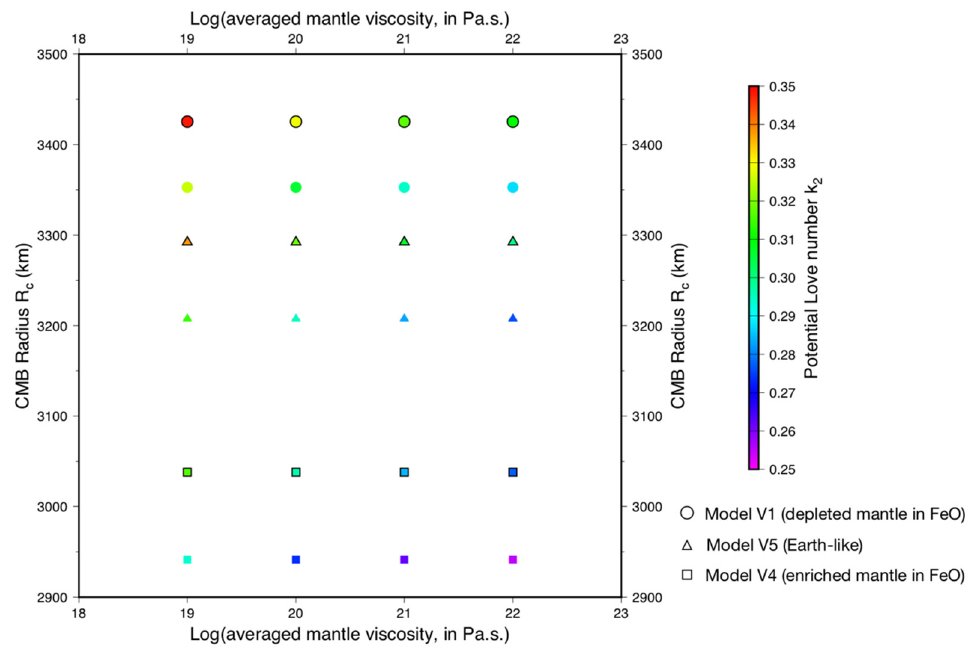
Table 1. Expected error (1- (cid:2252) ) (cid:2252) (cid:2173) of the EnVision solution and theoretical range ∆ Q of the Venus tidal dissipation factor Q as a function of the average mantle viscosity (see Table A2). The ∆ Q value for each averaged viscosity represents the variation of the viscoelastic deformation of the Andrade’s model used to account for the mantle rheology (see [14]). The (cid:2252) (cid:2173) error is derived from the error on the tidal phase angle (cid:2238)(cid:2261) (0.1° or 0.0017 radian, see Table A3) as follows: (cid:2252) (cid:2173) (cid:3406) (cid:2779)(cid:2173) (cid:2779) (cid:2238)(cid:2261) . Average Viscosity (Pa.s)